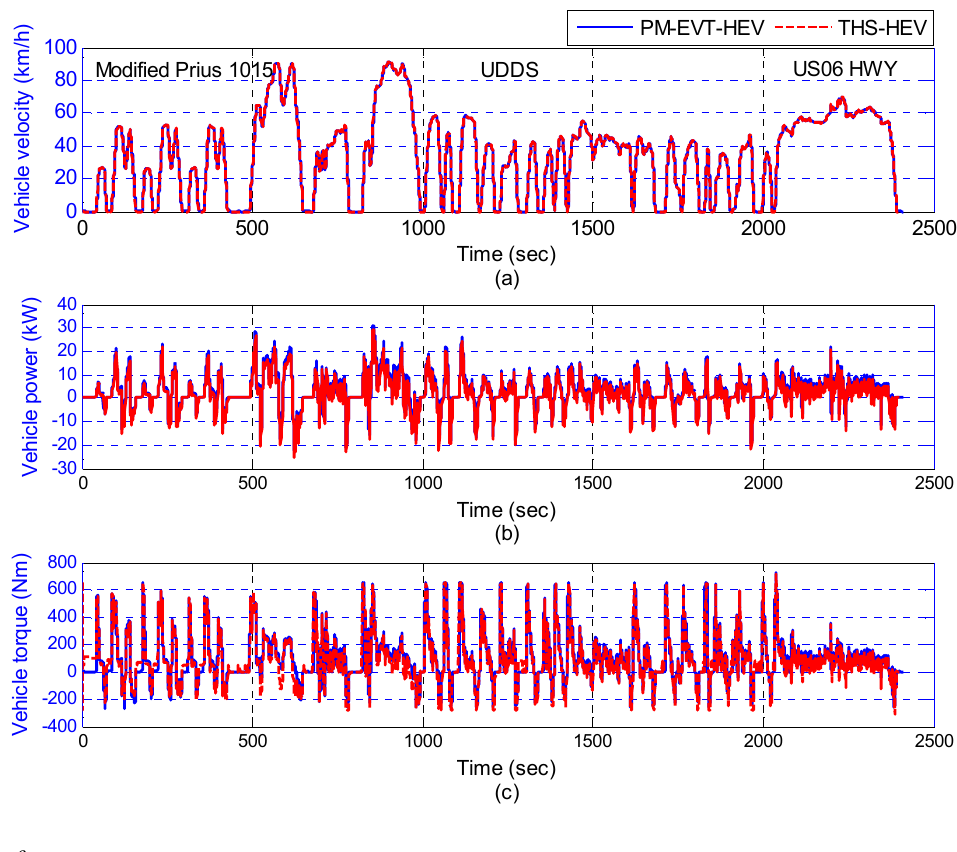
Figure 15. Vehicle performance of PM-EVT-HEV and Prius HEV with combined Modified Prius1015, UDDS, and US06 HWY drive cycles: ( a ) Vehicle’s velocity; ( b ) Vehicle’s power; ( c ) Vehicle’s